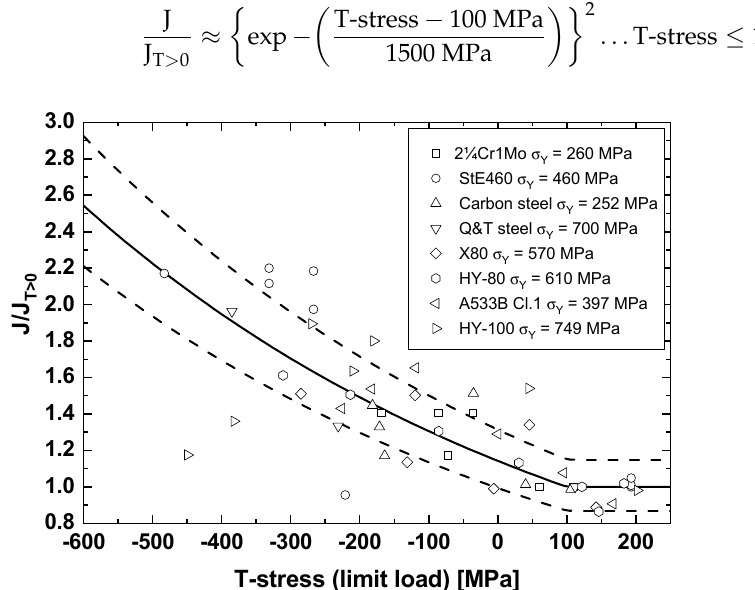
Figure 3. Effect of constraint expressed in the form of T-stress at limit load, on the J-integral for a specific crack growth compared to a high-constraint configuration (J/J T>0 ) [5]. Dashed lines indicate ±15% uncertainty.